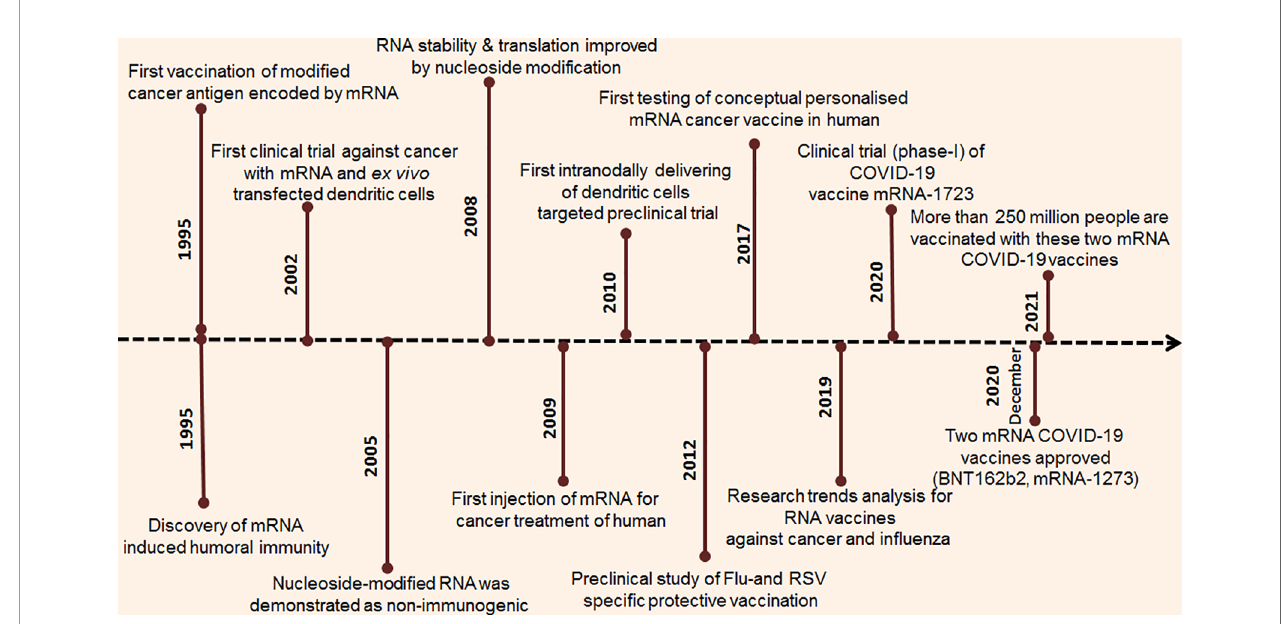
FIGURE 2 | Timeline of the research breakthrough and progression of mRNA